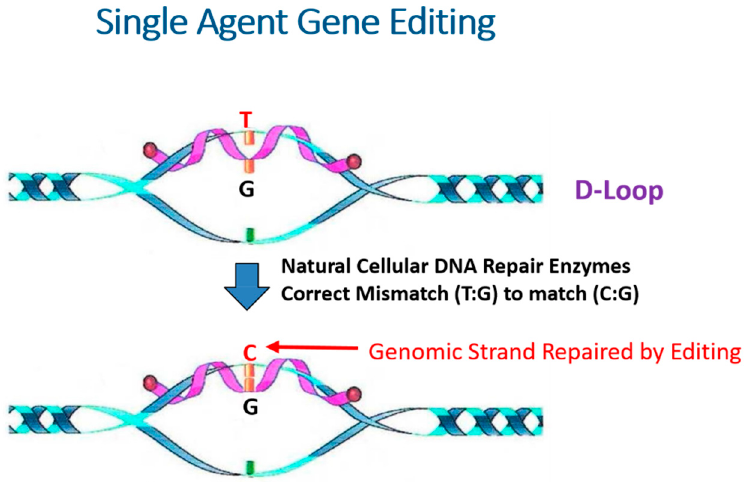
Figure 1. The D-Loop. A three stranded reaction intermediate is created when a single-stranded DNA molecule serving as the donor strand for homology directed repair interacts with this complementary strand within the helix. This step comprises the first phase of genetic engineering and DNA pairing. The dynamic binding of the single-stranded DNA with its complement creates the structure known as the D-loop. If a single nucleotide base is engineered into the donor strand so that it creates a mismatch with the nucleotide in the helix. Natural cellular DNA repair enzymes should then act to correct the mismatch and convert a mutant base to a normal base. This step comprises the second phase of gene editing known as DNA repairing.